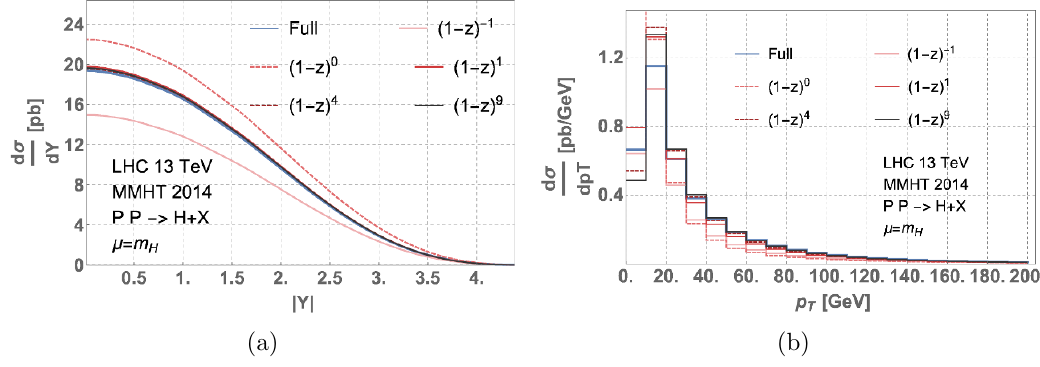
Figure 2. NNLO absolute rapidity (left) and transverse momentum (right) distribution for the Higgs boson. The blue line represents the exact result. Increasingly darker shades of red represent higher and higher truncation order of the threshold